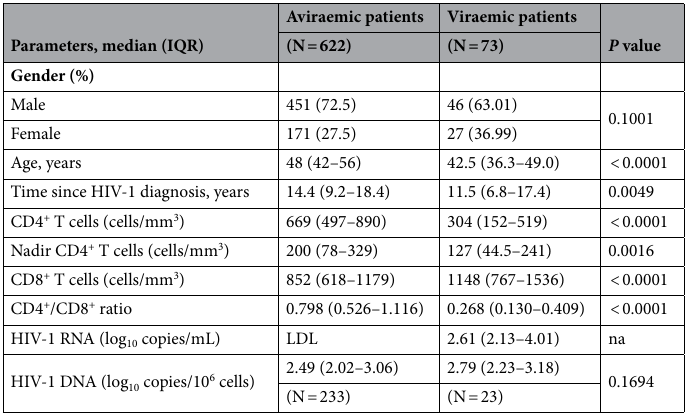
Table 1. Characteristics of HIV-1 infected patients enrolled in this study. IQR, interquartile range; LDL, lower than the detection limit of 20 copies of HIV-1 RNA/mL plasma; na, not applicable; Statistical significance ( P value) was determined by using the Mann–Whitney test or Fisher’s exact